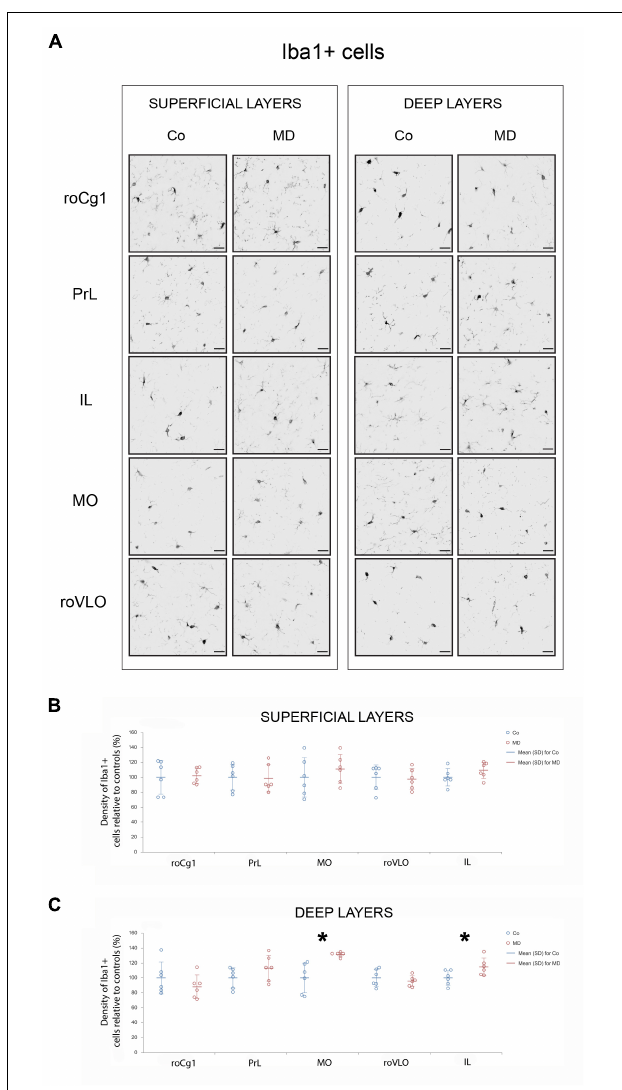
FIGURE 6 | Effects of MD on Iba1 + cell density in PFC on PND60. Representative photomicrographs of Iba1 + immunohistochemistry (A) . Dot plot graphs in (B,C) representing quantification of the results as means ± SD (horizontal bars) and observed values (dots), n = 6 per group in superficial and deep layers of the respective PFC area. MD rats had a higher density of Iba1 + cells in deep layers of MO and IL (C) . * p < 0.001 Co vs. MD. roCg1 rostral part of area 1 of cingulate cortex, Co control, IL infralimbic cortex, MD maternally deprived rats, MO medial orbital cortex, PrL prelimbic cortex, roVLO rostral part of the ventral lateral orbital cortex. Scale bars in (A) correspond to 25 µ